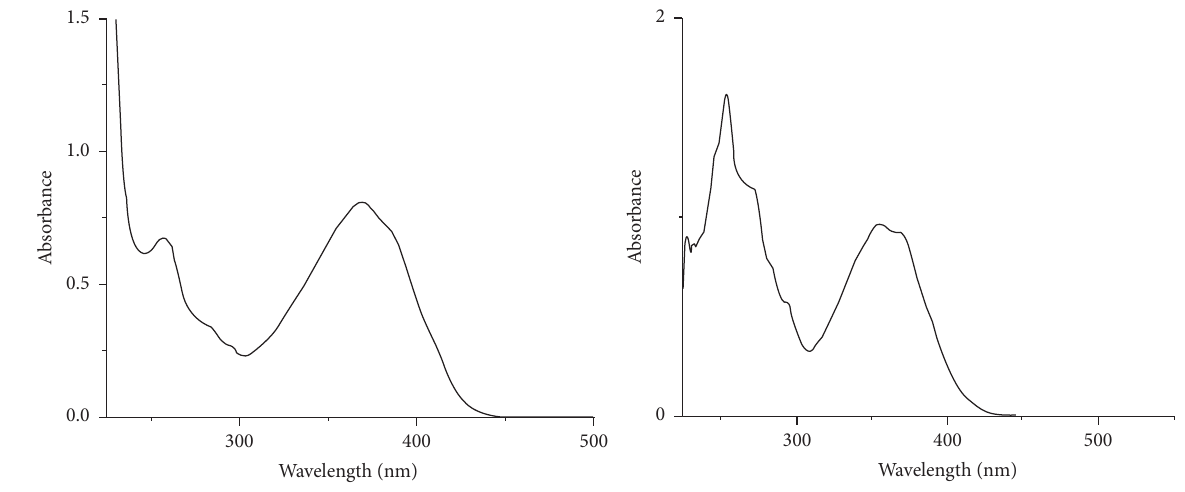
Figure 2: UV spectra of compounds 1 and 4 , respectively.